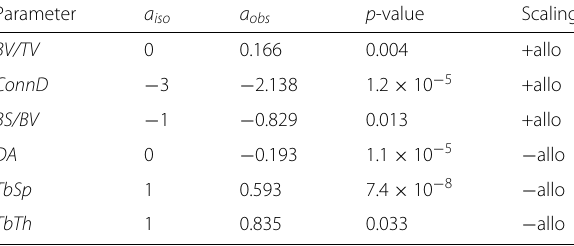
a iso - expected scaling exponent under isometry a obs - observed scaling exponent p -value - tests null hypothesis a obs = a iso +/ − allo - positive or negative